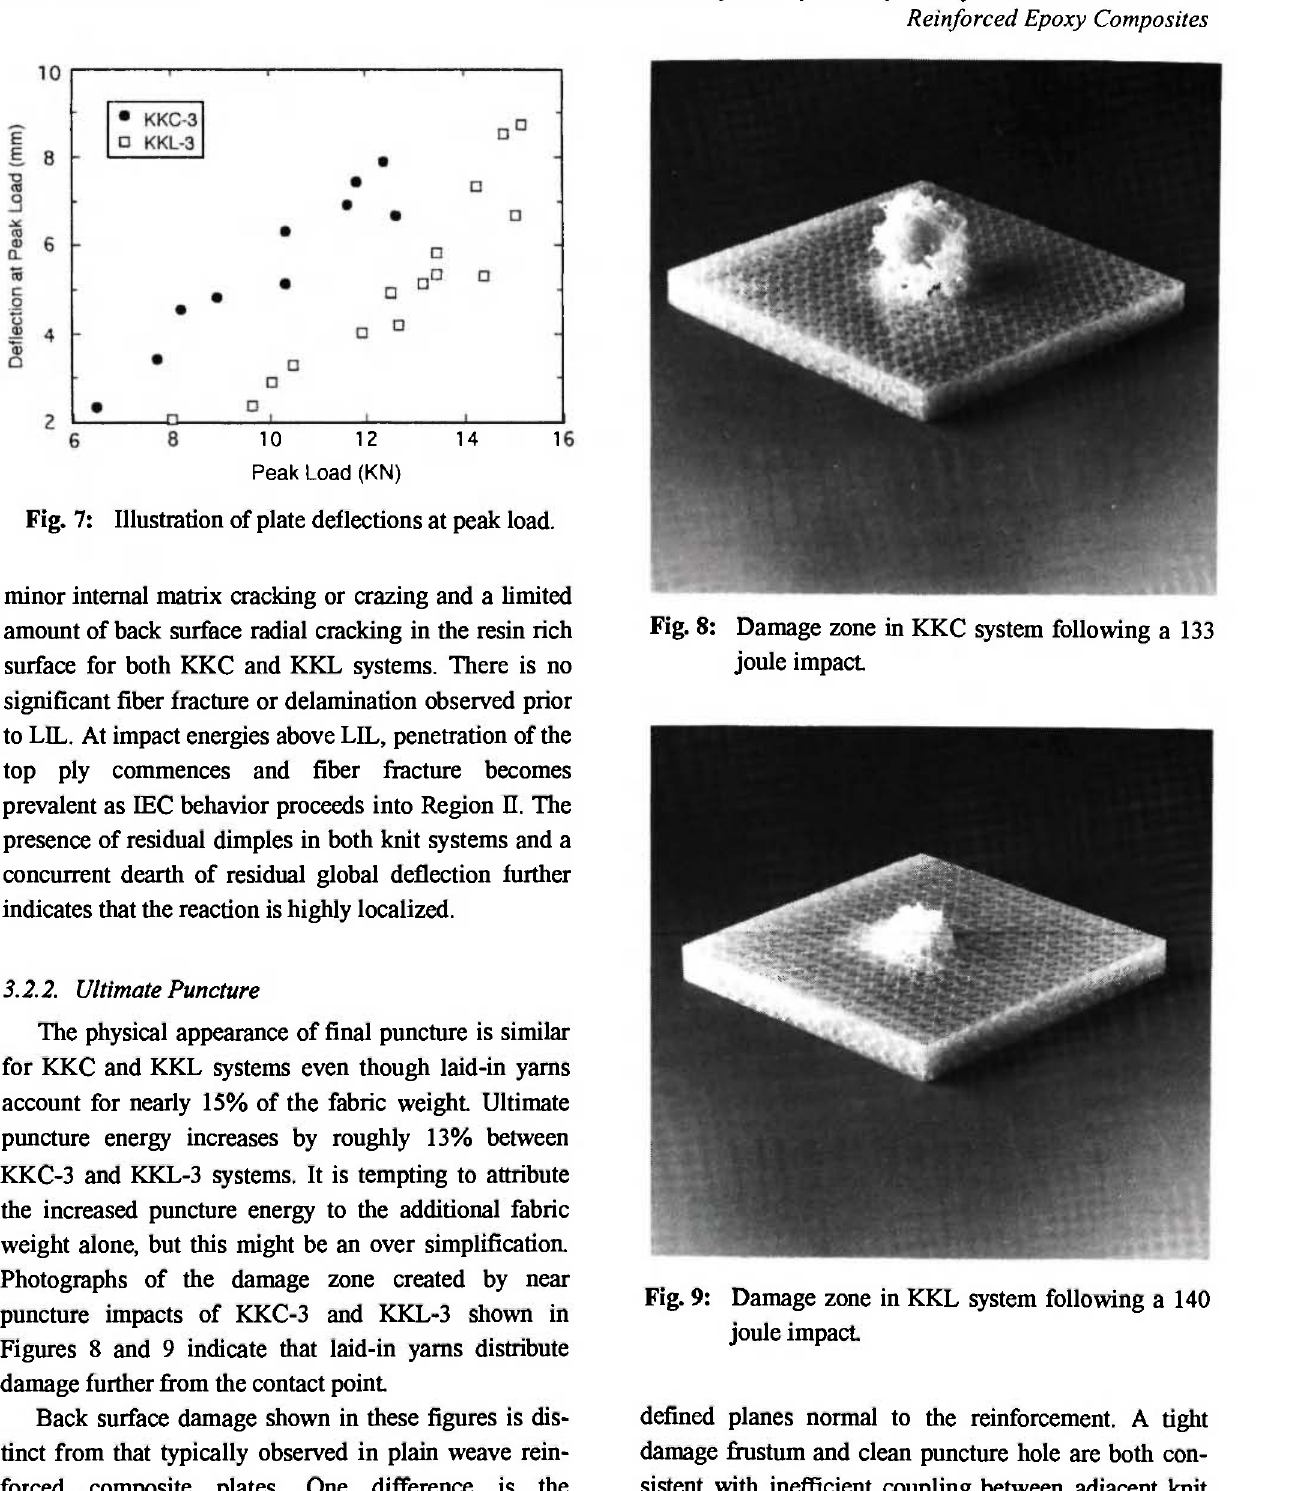
Fig. 7: Illustration of plate deflections at peak load.